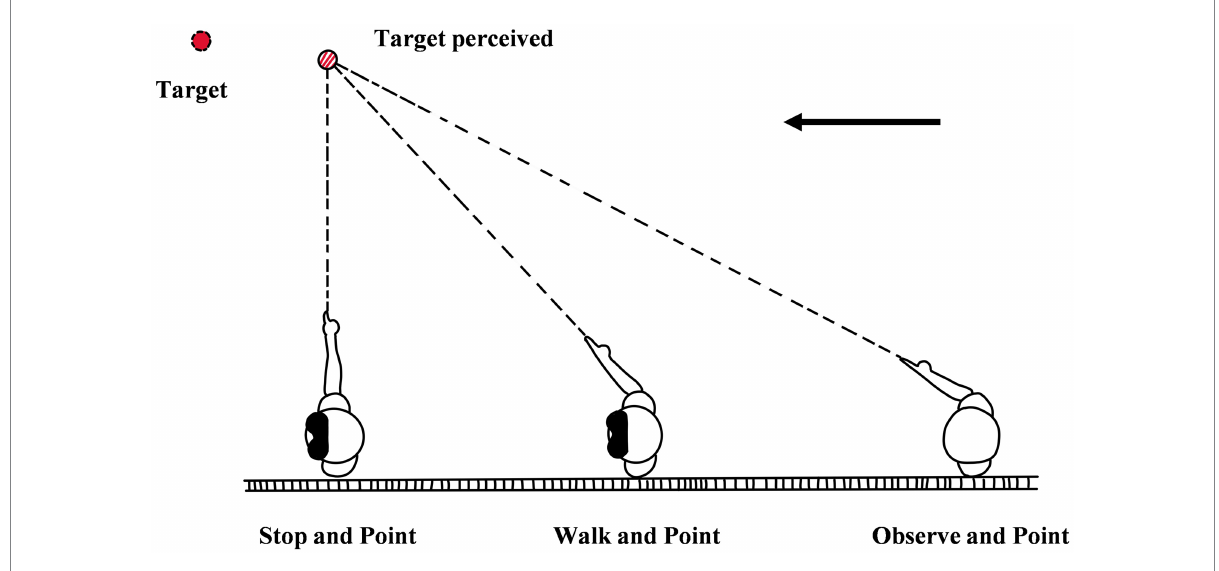
FIGURE 8 The diagram of triangulation-by-pointing [referenced and modified from Loomis et al.,